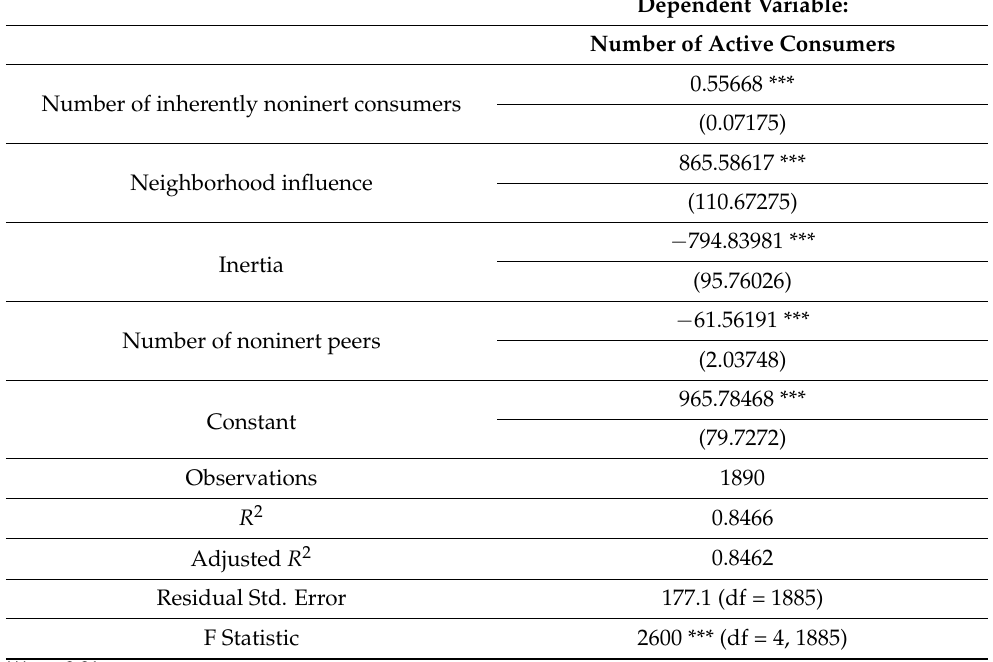
Table 2. Consumer inertia